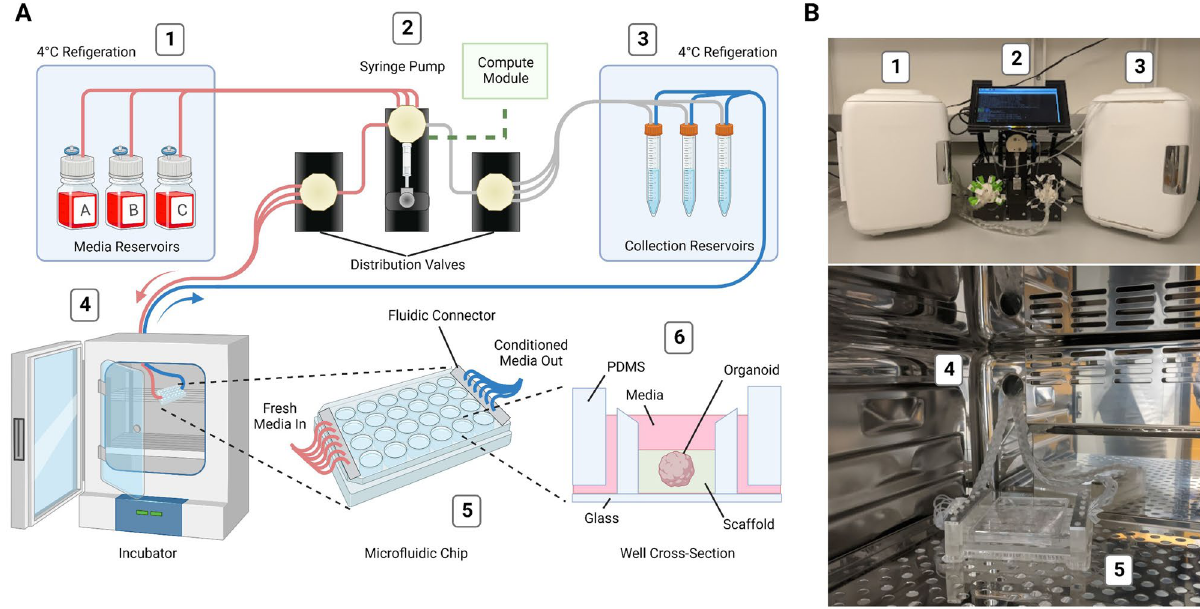
Figure 2. Design and implementation of the automated, microfluidic culture platform. ( A ) Illustration of the automated, microfluidic organoid culture platform, the Autoculture . ( B ) Front view images of the Autoculture . (1) Refrigerator with reagent reservoirs. (2) Syringe pump, distribution valves, and control interface. (3) Refrigerator with conditioned media collection reservoirs. These components reside on a lab bench directly above the cell culture incubator. (4) Microfluidic tubes enter through an incubator port and connect to the (5) microfluidic well plate chip inside the incubator. (6) Cross-sectional diagram of a single well containing an organoid